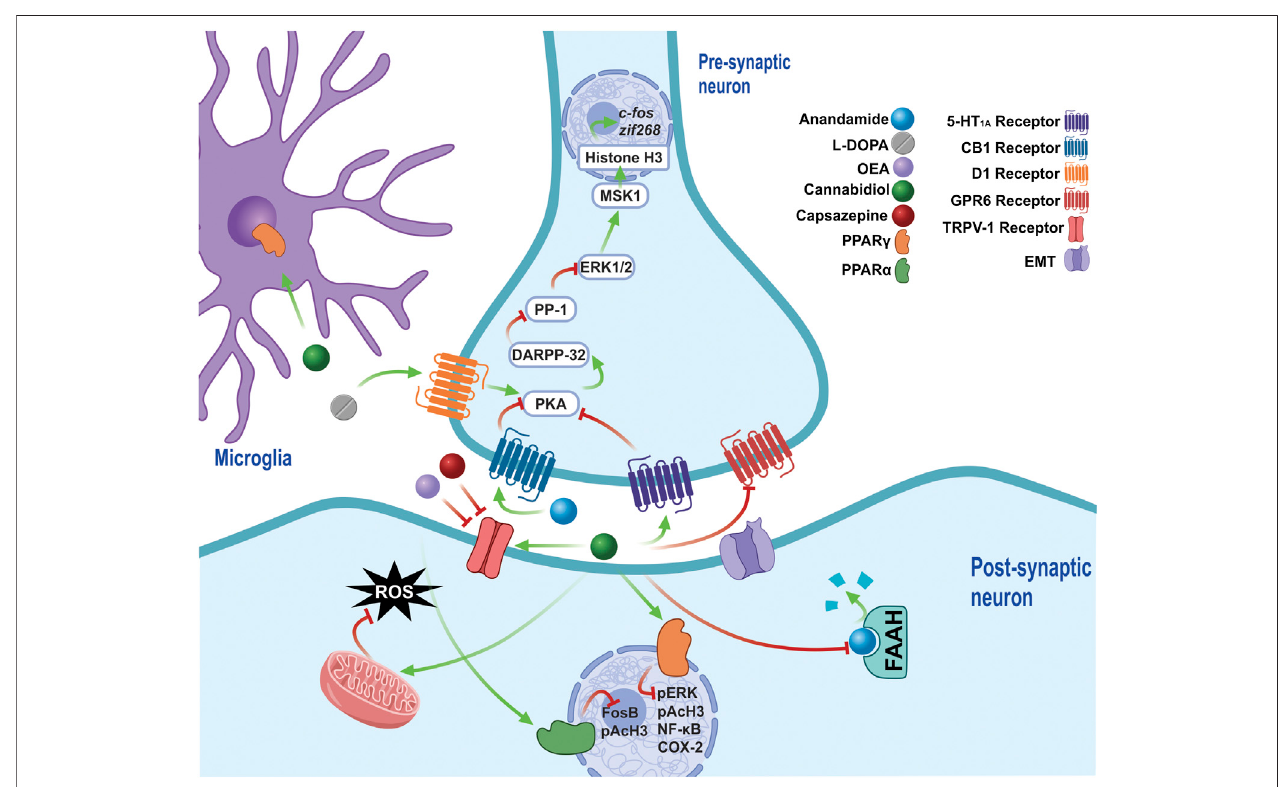
FIGURE 7 | The chronic administration of L -DOPA leads to a sensitization of D1 receptors, which maintain the over-activation of PKA in LIDs. PKA regulates the pathway that activates DARPP-32, which inhibits the modi fi cation by PP-1, of ERK1/2 signaling, which acts on nuclear targets, such as MSK1, and, along with histone H3, regulates the expression of early genes such as c-fos and zif268. CBD exerts antidyskinetic effects by increasing AEA concentration by inhibiting of FAAH, thus stimulatingtheCB1receptors,whichdecrease PKA activity. TheCB1requiere theco-administrationofaTRPV1 inhibitor (CPZ), becausetheystimulateTRPV1 via AEAandCBD,bothofwhichgenerateoppositeeffectstotheactivationofCB1.Furthermore,increasedOEAisgeneratedviatheinhibitionofFAAH,anendocannabinoid able to block TRPV1 and stimulate PPAR σ receptors, reducing biochemical markers such as FosB and pAcH3. In addition, CBD activate the 5-HT1A receptor, a receptor that had previously only been implicated in the anticataleptic effect of CBD. By activating PPAR γ receptors, CBD reduces the levels of molecular markers involvedinLIDs,suchaspERK,pAcH3,NF-K β andCOX-2,whileitalsogeneratesananti-in fl ammatoryeffectbystimulatingsaidreceptors,whicharepresentintheglia. Furthermore,CBDisabletoreduceoxidativedamage,decreasingtheproductionofROSbyincreasingtheactivityofmitochondrialcomplexes.Theinverseagonismthat CBD exerts on GPR6 could form part of its antidyskinetic mechanisms. Abbreviations: L -DOPA, L-3,4-Dihydroxyphenylalanine; D1, Dopamine receptor 1; PKA, cAMP- dependent protein kinase; LID, L -DOPA-induced dyskinesias; DARPP-32 – 32 KDa Phosphoprotein regulated by cAMP and dopamine; PP-1, phosphoprotein 1; ERK, extracellular signal-regulated kinase; MSK-1, mitogen and stress regulated protein kinase; CBD, cannabidiol; AEA, anandamide; FAAH, fatty acid amide hydrolase; TRPV1, transient potential receptor V1; CPZ, cpazazepine; OEA, oleoylethanolamide; PPAR α , peroxisome proliferator activated receptor α ; pAcH3, Histone 3 phosphoacetylation; 5HT1A, Serotonin receptor 1A; PPAR γ , peroxisome proliferator activated receptor γ ; NF-K β , nuclear factor K β ; COX-2, cyclooxygenase 2.